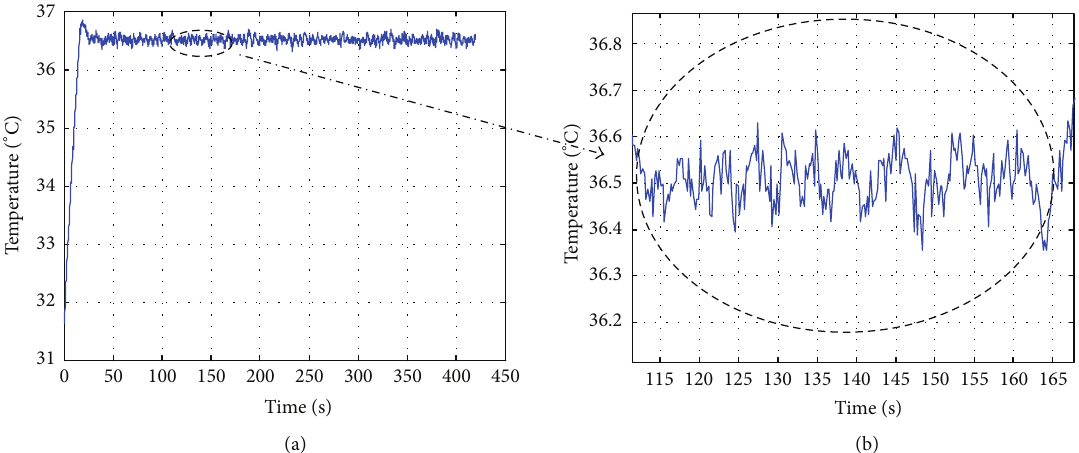
Figure 18: (a) Temperature characteristic of temperature closed-loop control circuit with start temperature at 31.65 ∘ C. (b) Temperature characteristic partial enlarged detail.